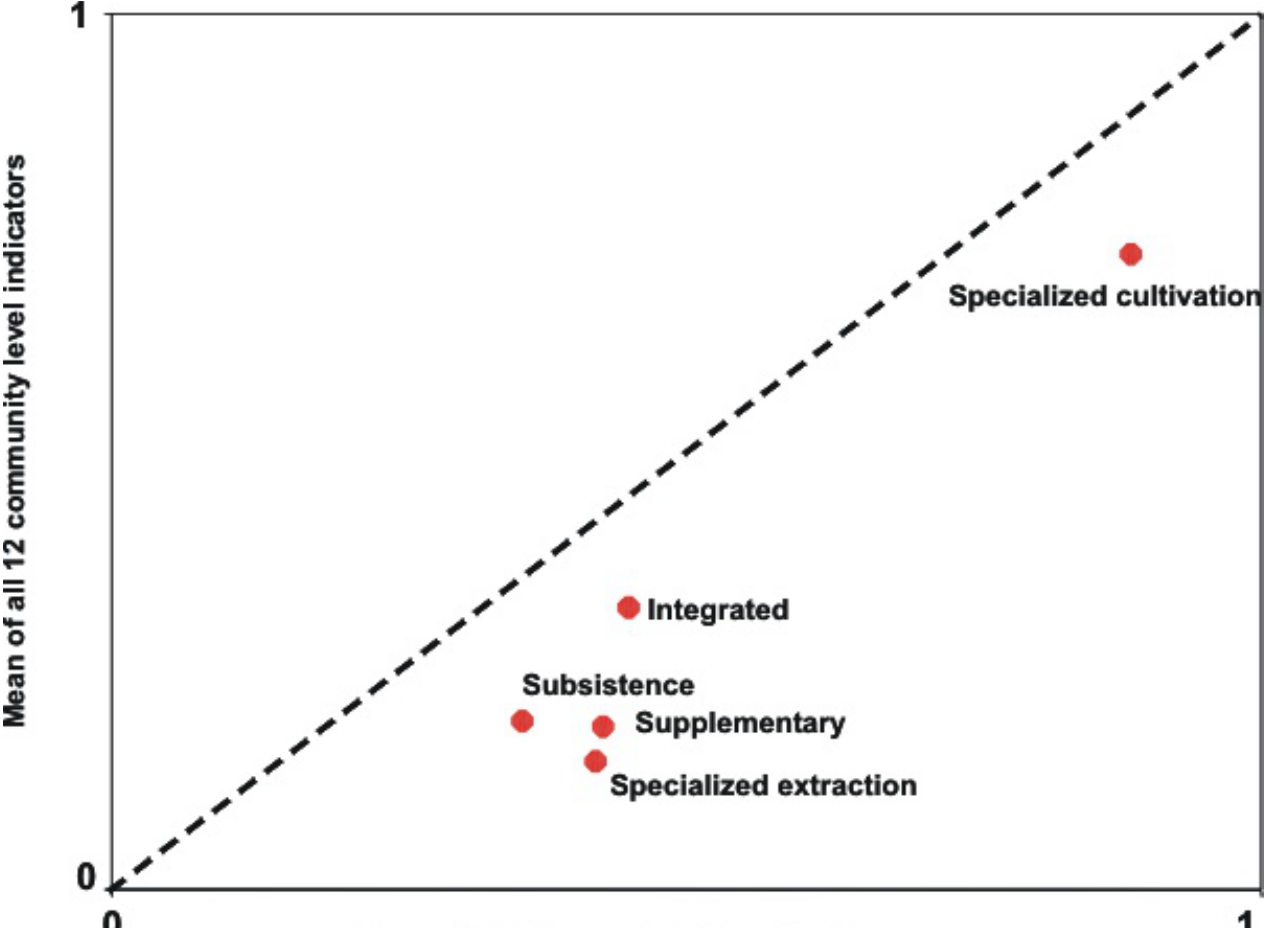
Fig. 3. Mean scores of livelihood indicators at the household level vs. the community